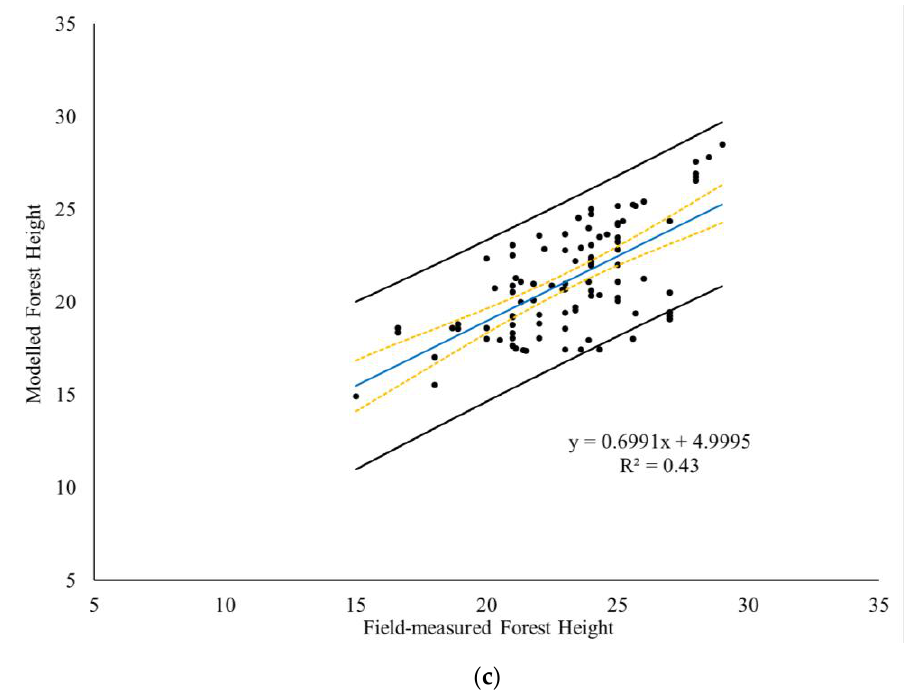
Figure 12. Linear regression with 95% confidence interval for TSI-based inversion modelling of ( a ) L-band SAR data, ( b ) C-band SAR data, and ( c ) X-band SAR data.